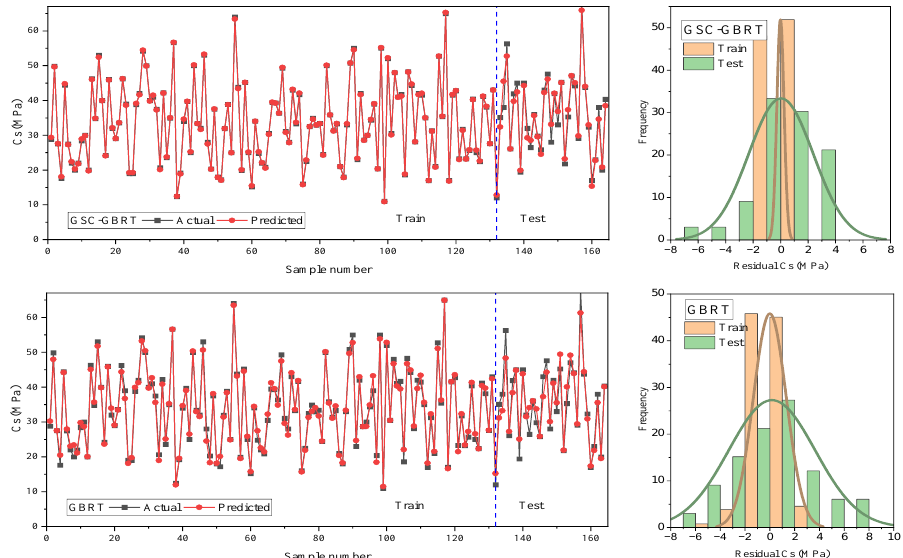
Figure 7. Model errors between targets and predictions for testing set ( a ) GSC-GBRT, ( b ) GBRT. The multiple linear regression and M5P models [59,60] are compared with the GSC- GBRT model in order to more accurately depict the accuracy of the last one. Multiple lin- ear regression and M5P were used to obtain the predictions, and an 8:2 dataset division ratio was used. Figure 8 depicts the correlation between the estimated and actual Cs.